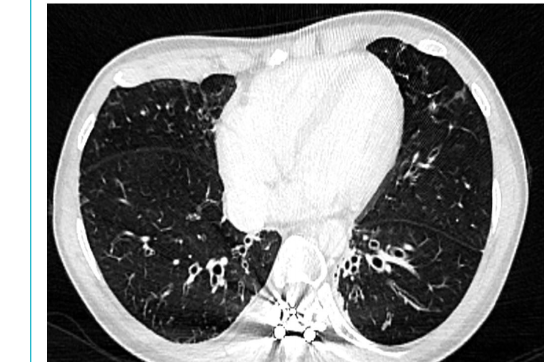
Figure 2: Thoracic computed tomography confirming the X-ray findings.